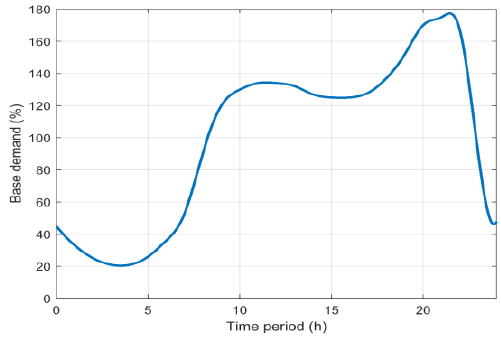
Figure 6. Network schematic with points for hydro-turbine installation.